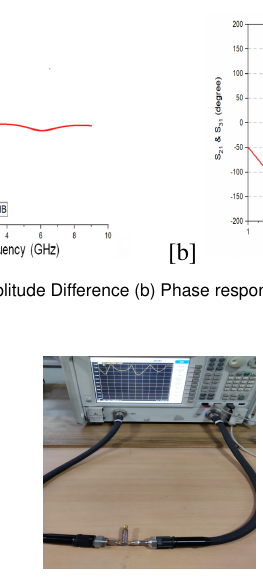
FIGURE 6. Measurement using Network Analyzer Agilent